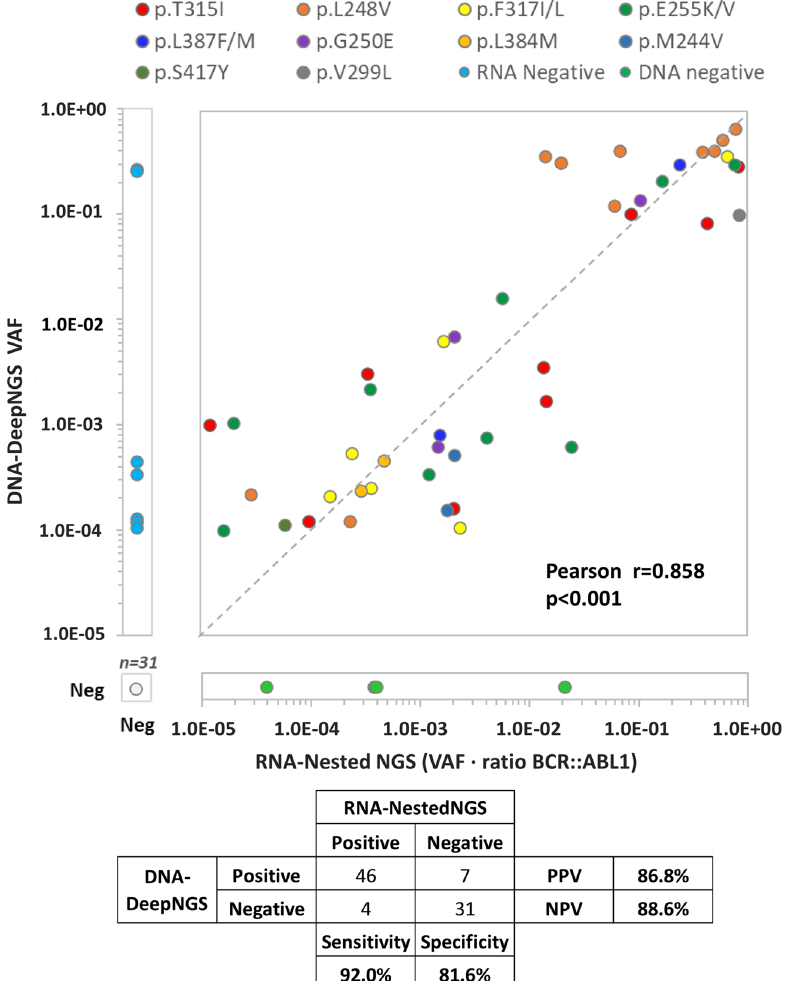
Figure 4. Correlation and metrics for the comparation of both methodologies. The VAF of the RNA- NestedNGS approach was corrected by the BCR::ABL1 levels. Different hotspots are represented by different colors. The dashed line represents 100% concordance. VAF variant allele